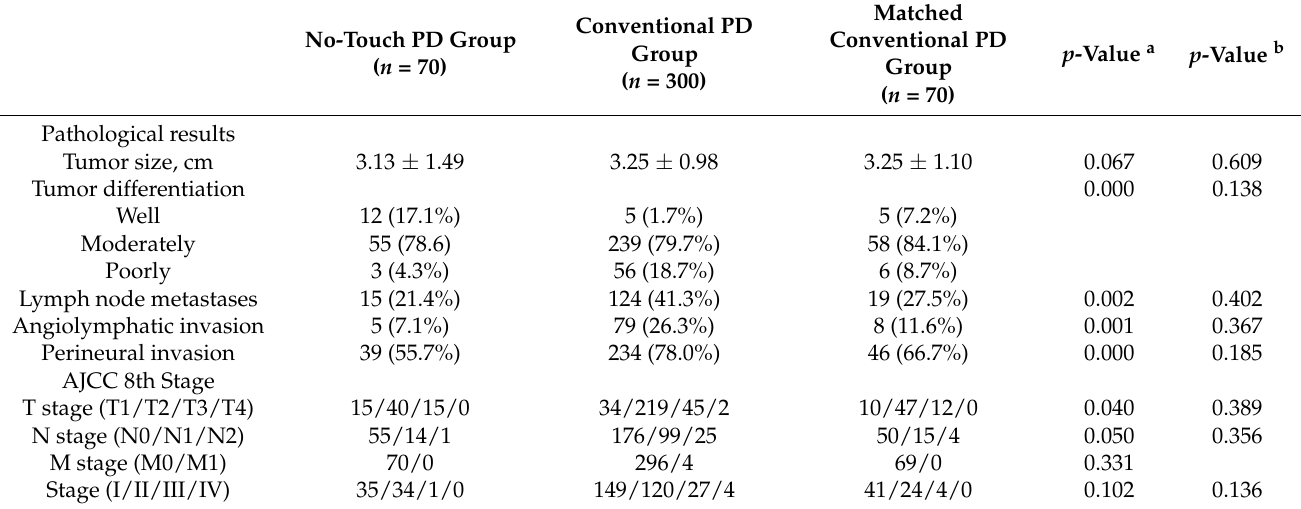
Table 3. Pathological